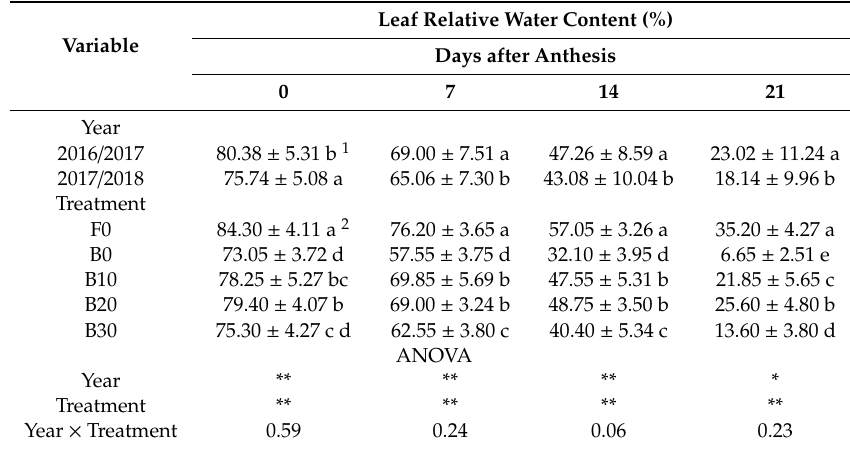
Table 7. Main effects of year and treatment on leaf relative water content at 0, 7, 14, 21 days after anthesis. Leaf Relative Water Content (%) Variable Days after